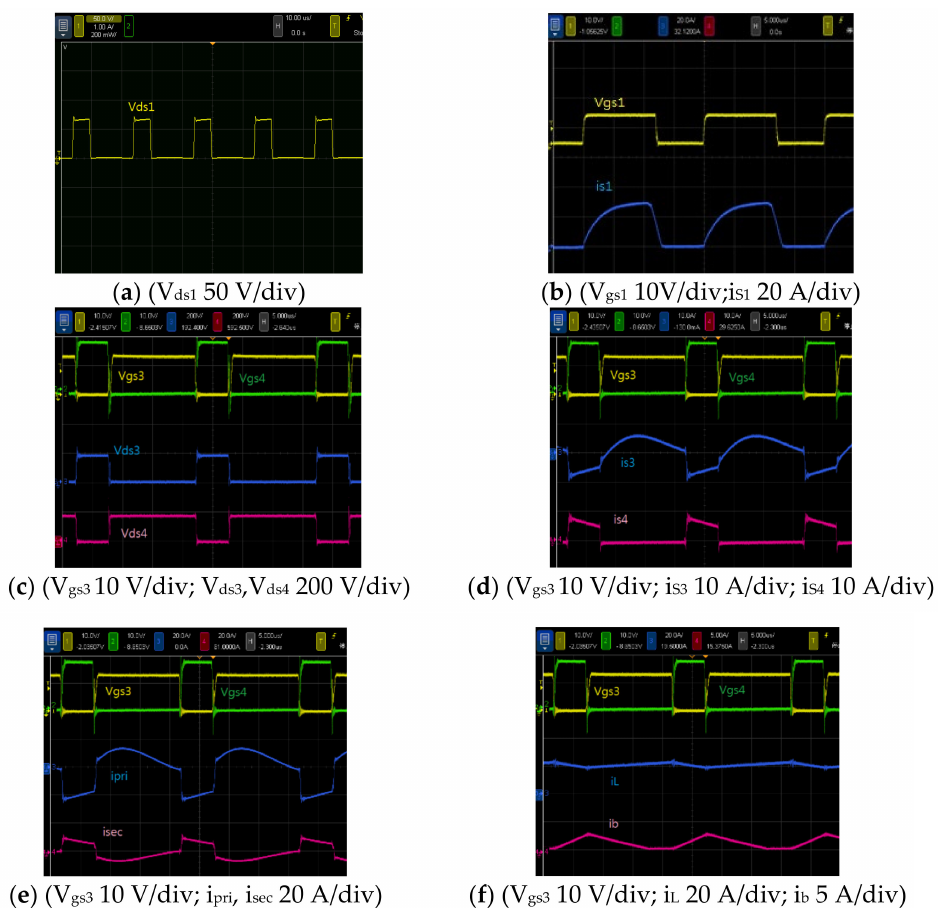
Figure 16. Measured results under Stage 2 at 500 W: ( a , b ) switch S 1 waveforms, ( c , d ) switches S 3 and S 4 waveforms, and ( e , f ) current waveforms of transformers and inductors, respectively.